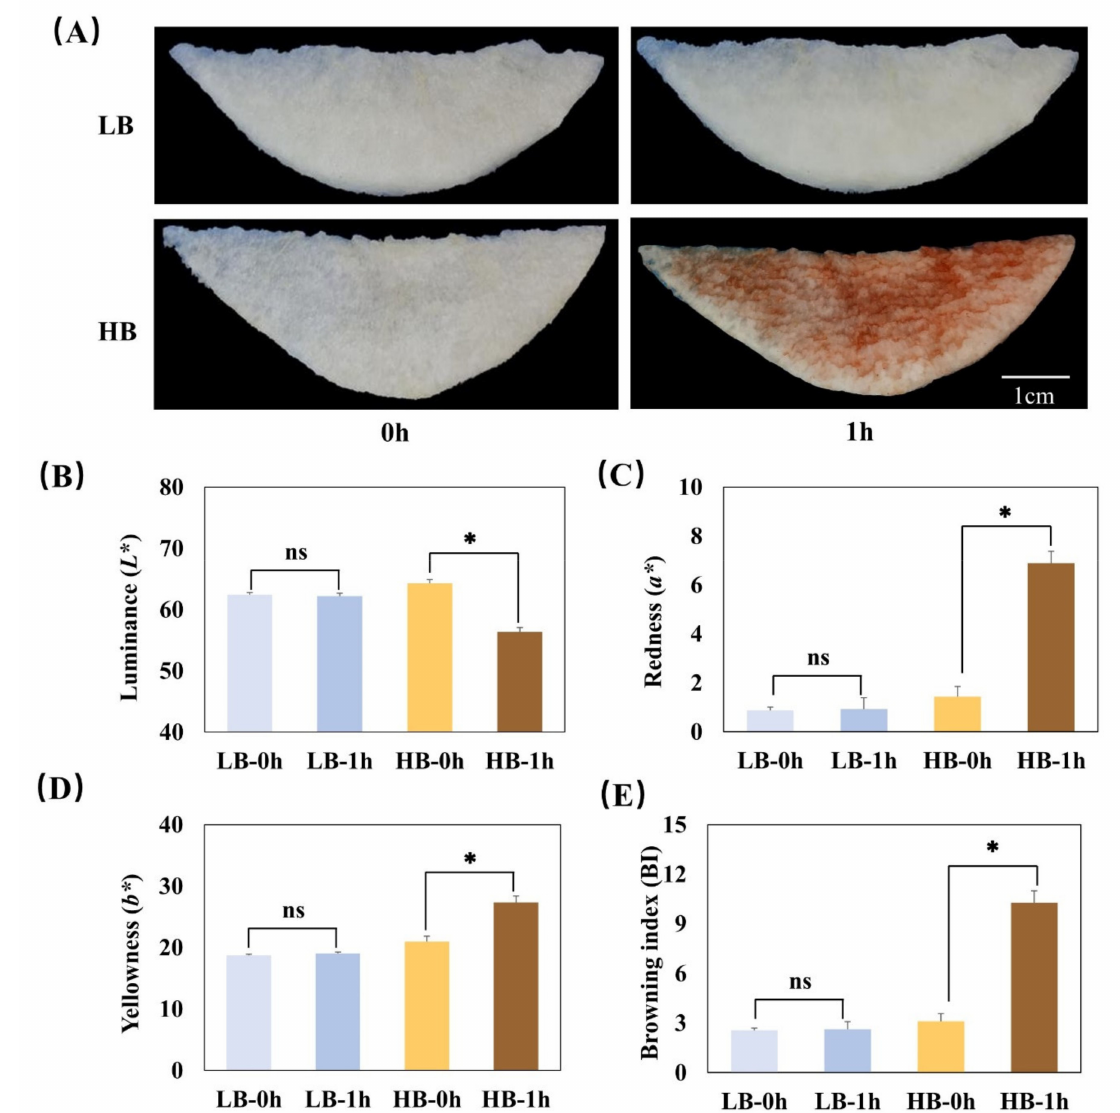
Figure 1. Flesh browning of two sand pear cultivars at 0 h and 1 h. ( A ) Sand pear flesh slices browning of LB (low browning cultivar ‘Eli No.2 (cid:48) ) and HB (high browning cultivar ‘Weiningdahuangli’). ( B – E ) Changes in color coordinates L* ( B ), a* ( C ), b* ( D ), and browning index ( E ). Scale bar = 1 cm; * indicates statistical significance ( p < 0.05), ns: no